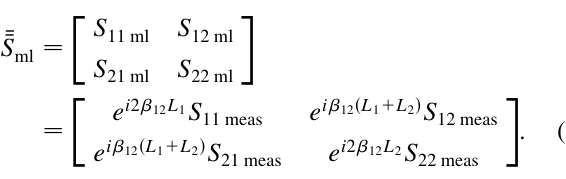
Fig. 4 from the knowledge of